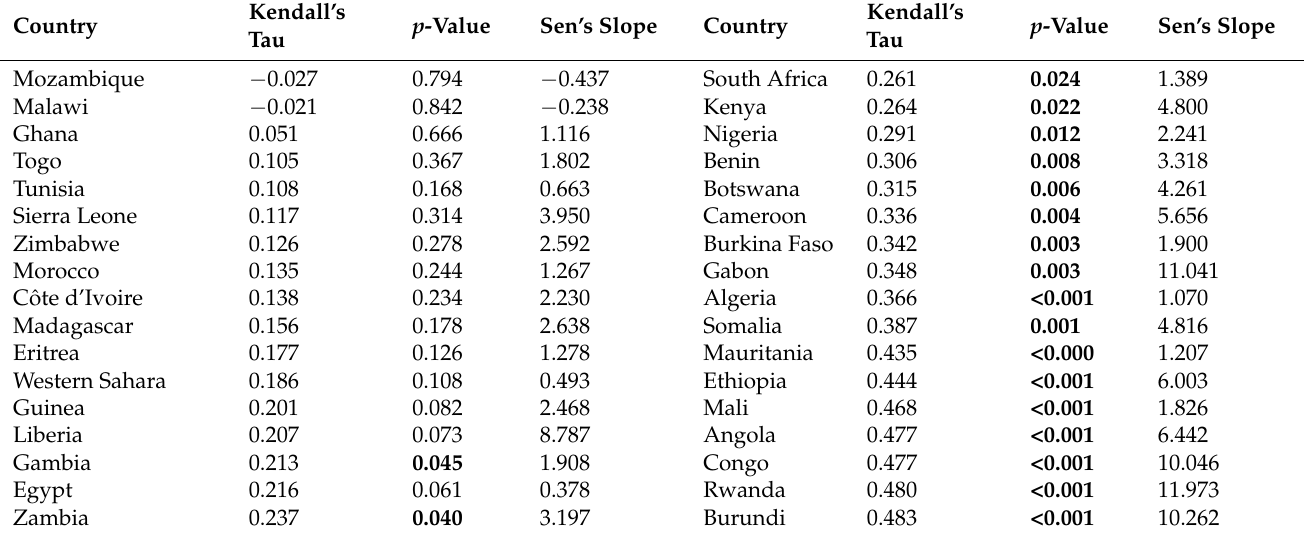
Table 4. Kendall’s Tau, p -value, and Sen’s slope for annual rainfall for African countries (1983–2020). Bold numbers in p -values represent the statistically significant